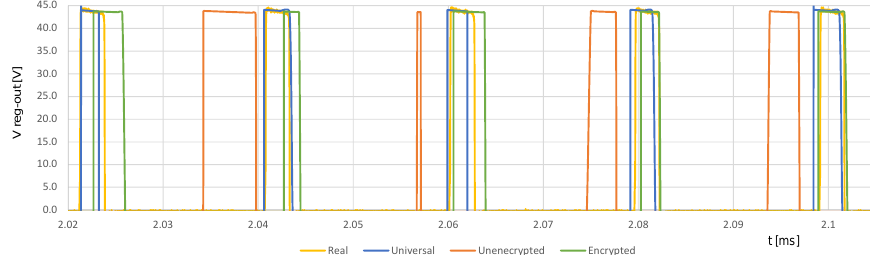
Figure 14. V reg-out models and real measurement time graph curves.